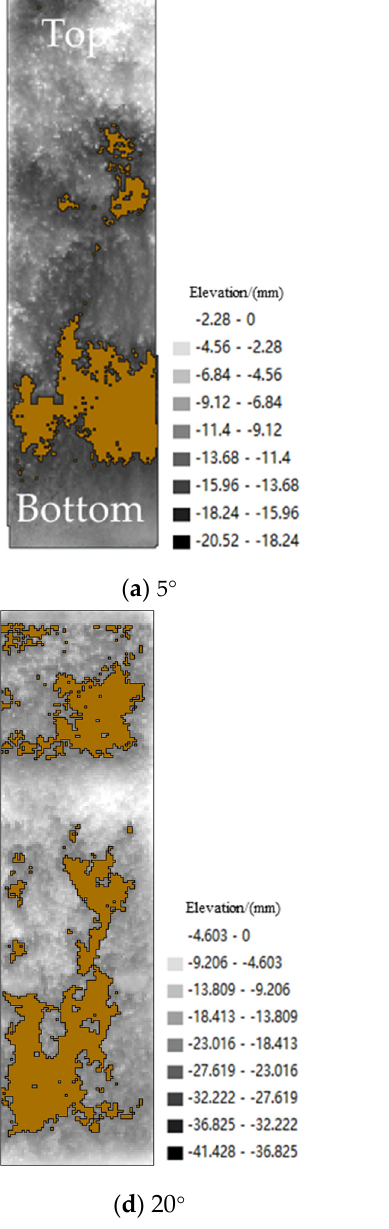
Figure 6. Severe areas of slope erosion under different slope gradients.